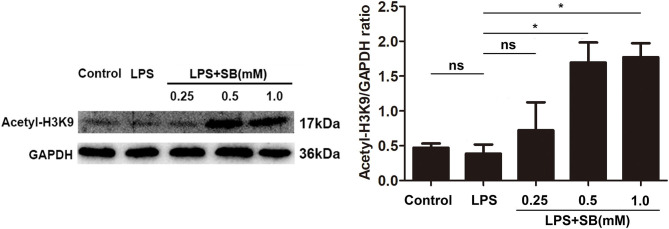
Sodium butyrate enhanced H3K9 acetylation. The cells were incubated with various concentrations of sodium butyrate (0.25, 0.5, 1 mM) for 12 h before adding LPS for 3 h. The protein level of H3K9 was analyzed by western blotting. The quantification of band intensity was determined by densitometry and normalized to GAPDH. Values were shown as means ± SD (n = 3). nsp > 0.05 meant no significance, *p < 0.05 compared to the LPS group.